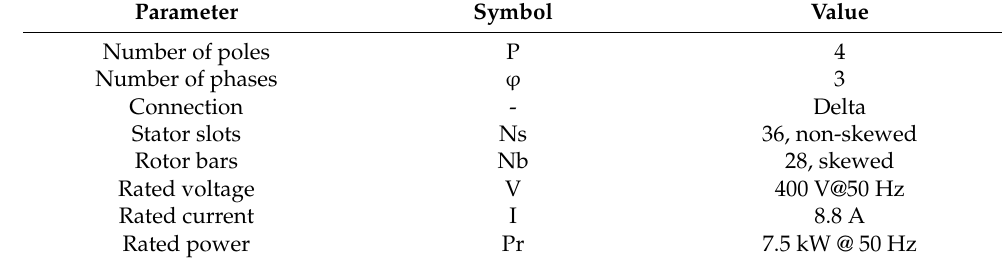
Table 2. The machine specifications. Table 3. The setting of the industrial inverter to achieve the desired voltage.